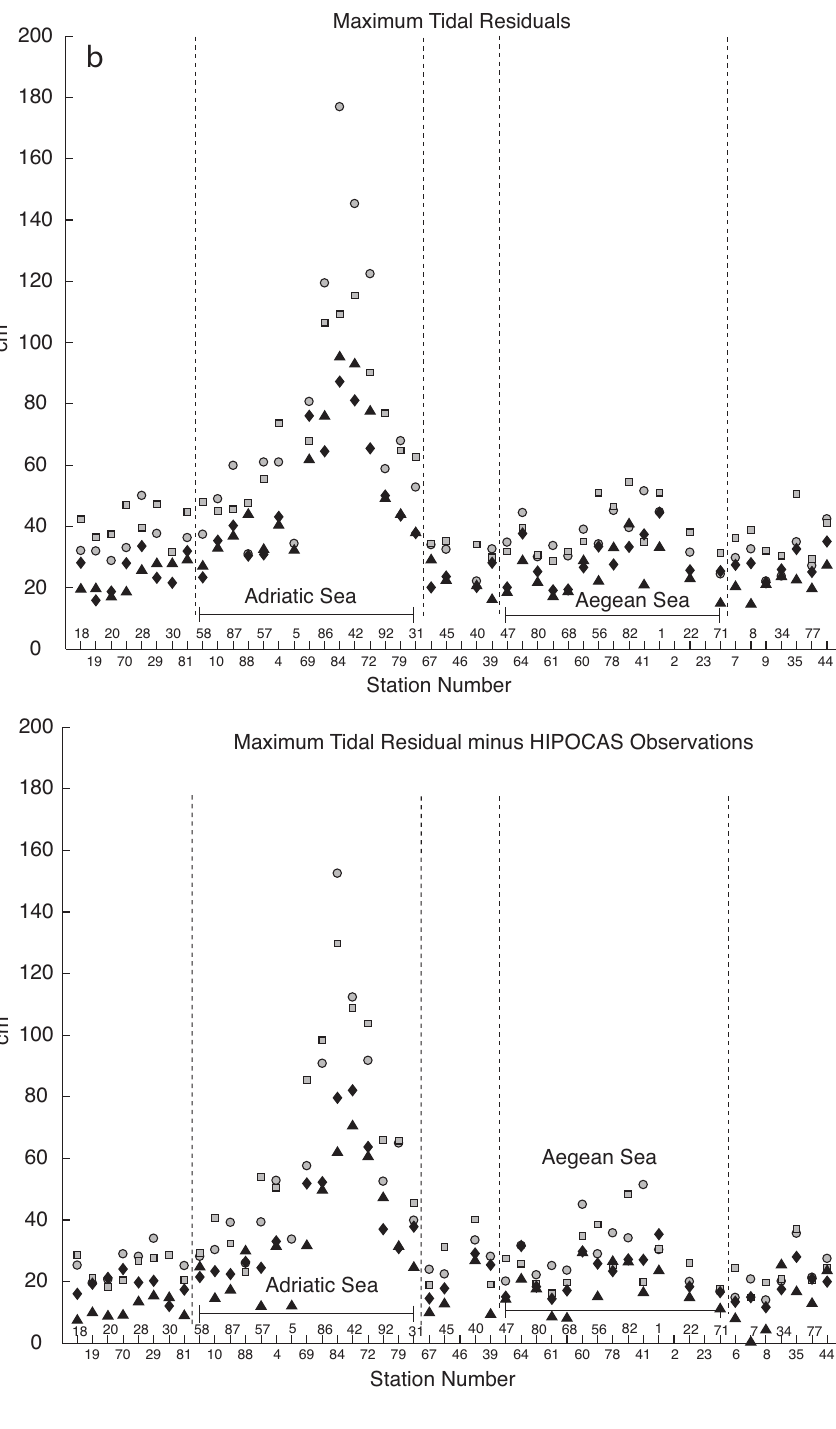
tide-gauges. Figure 5. As Figure 3 for the eastern Mediterranean Fig. 5. As Fig. 3 for the eastern Mediterranean tide-gauges. son with other seasons.